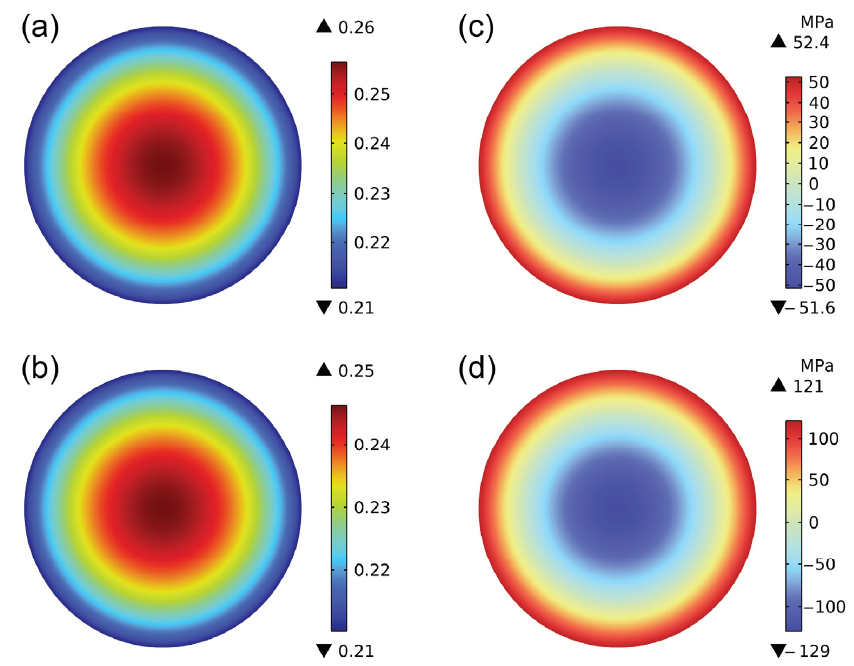
Figure 8. ( a ) Representative contour plots for ( a , b ) lithium concentration distributions ( 𝑐 𝑐 (cid:3047)(cid:3042)(cid:3047)(cid:3028)(cid:3039) ⁄ ) and ( c , d ) first principal stress at the end of the delithiation. The results ( a , c ) are based on a constant partial molar volume, and ( b , d ) were obtained using a concentration-dependent partial molar vol-